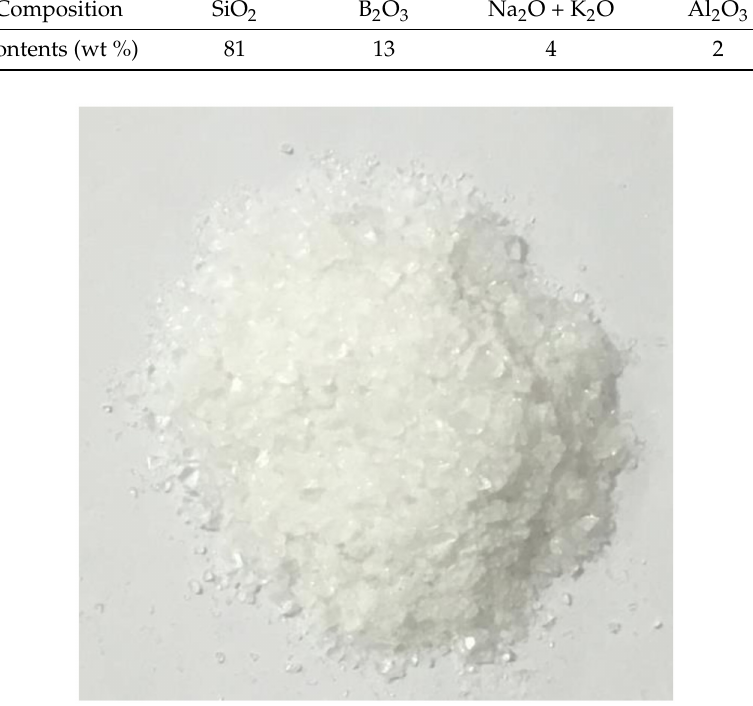
Table 1. The chemical composition of borosilicate glass.